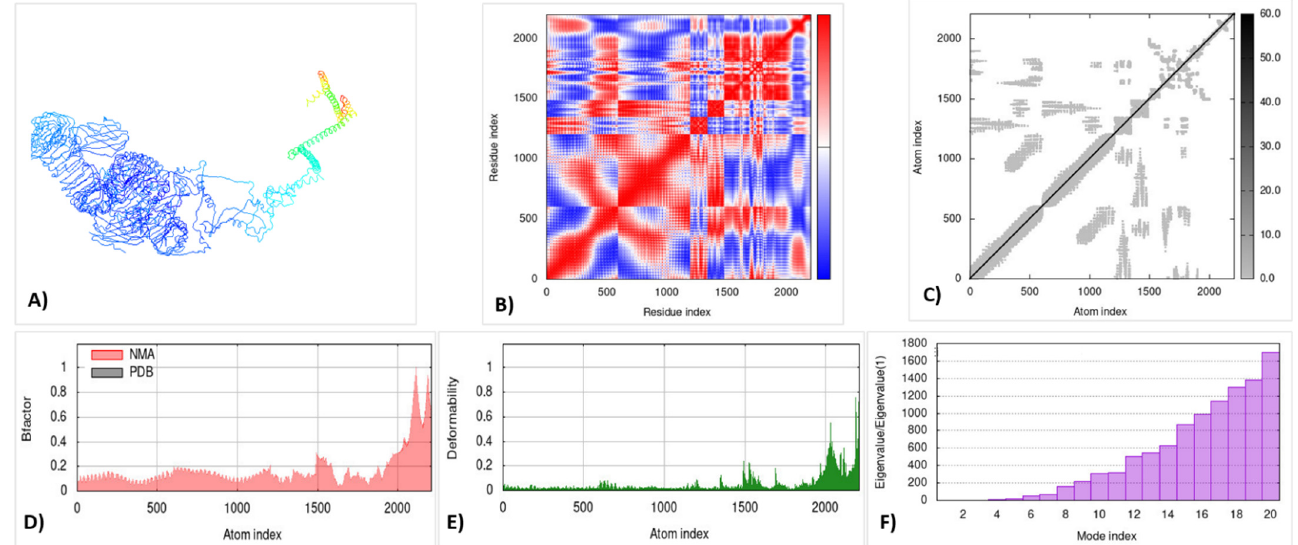
Figure 6. The receptor–ligand interactions, normal mode analysis, and molecular dynamics simula- tion: ( A ) vaccine–TLR-4 docked complex using the Cluspro server; ( B ) covariance matrix; ( C ) elastic network model using the iMODS server; ( D ) B-factor graph; ( E ) deformability graph; ( F ) Eigenvalue of the vaccine–TLR4 complex.